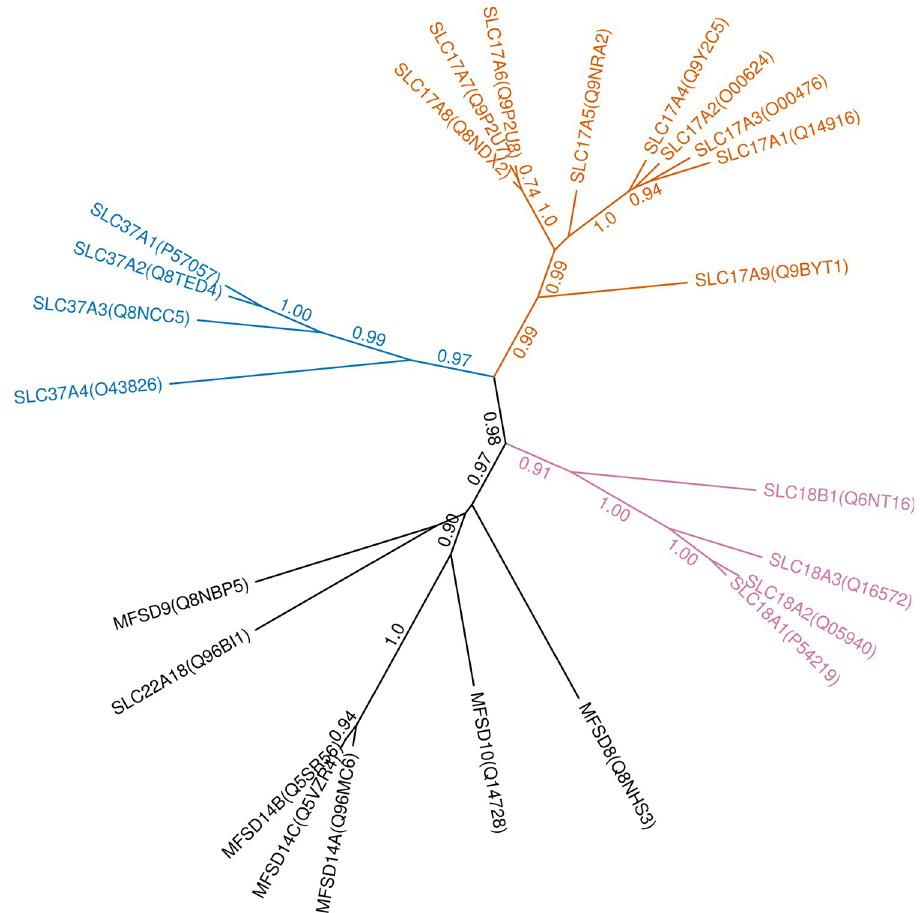
Fig 3. Phylogenetic tree of the SLC17, SLC18 and SLC37 families and proteins clustering in their neighborhood. Branch support values � 0.7 are shown.